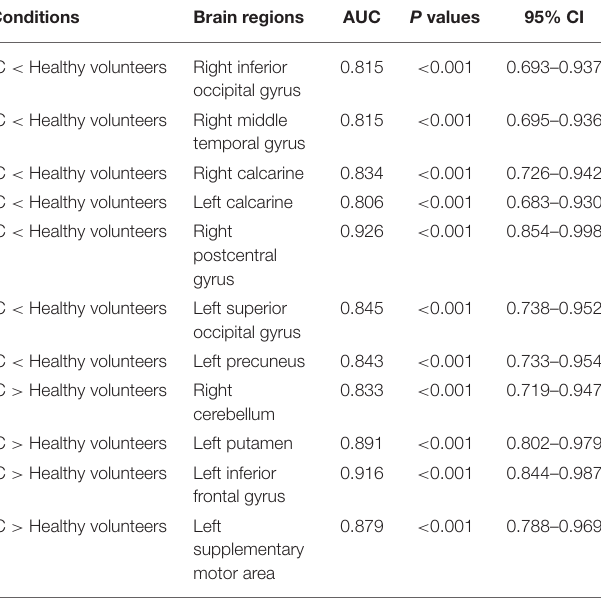
TABLE 3 | ROC curves for the mean ReHo of changed brain